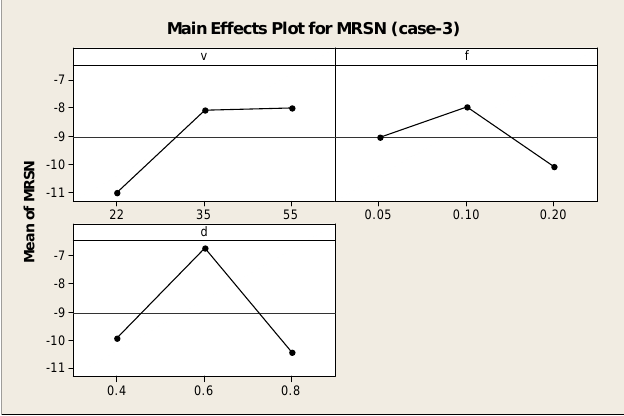
Fig. 6. Main effect plot for MRSN